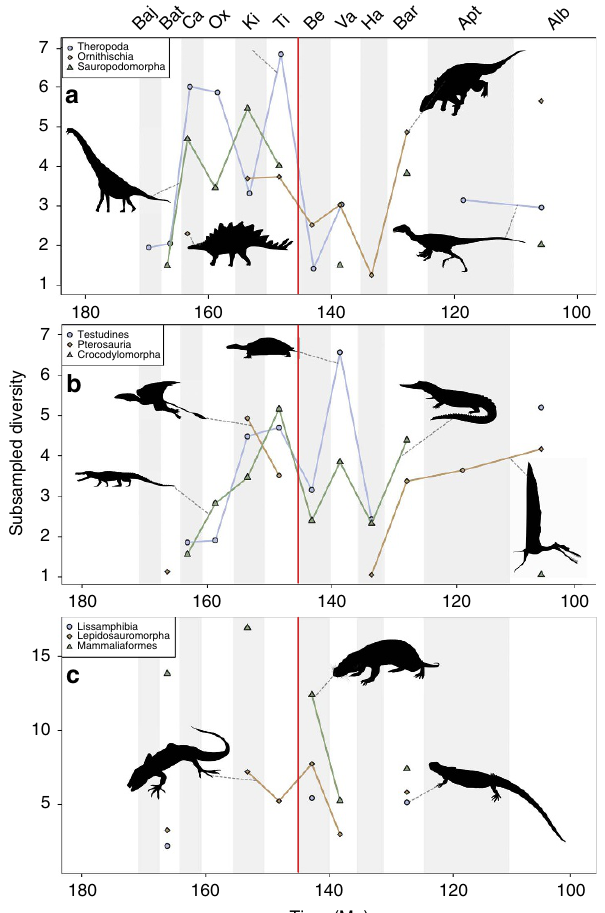
Figure 2 | Global non-marine Late Jurassic to Early Cretaceous subsampled diversity. SQS diversity for ( a ) major dinosaur groups; ( b ) testudines, crocodylomorphs and pterosaurs; and ( c ) mammals, lepidosaurs and lissamphibians. Shaded areas represent stage boundaries. Where gaps in the curve exist this is due to poor sampling and failure to adequately recover a subsampling diversity estimate. Silhouettes from Phylopic courtesy of Michael Keesey, Grad McFeeters, Scott Hartman, Mark Witton, Ville Veikko Sinkkonen and Hanyong Pu (see http://phylopic.org/ for additional license